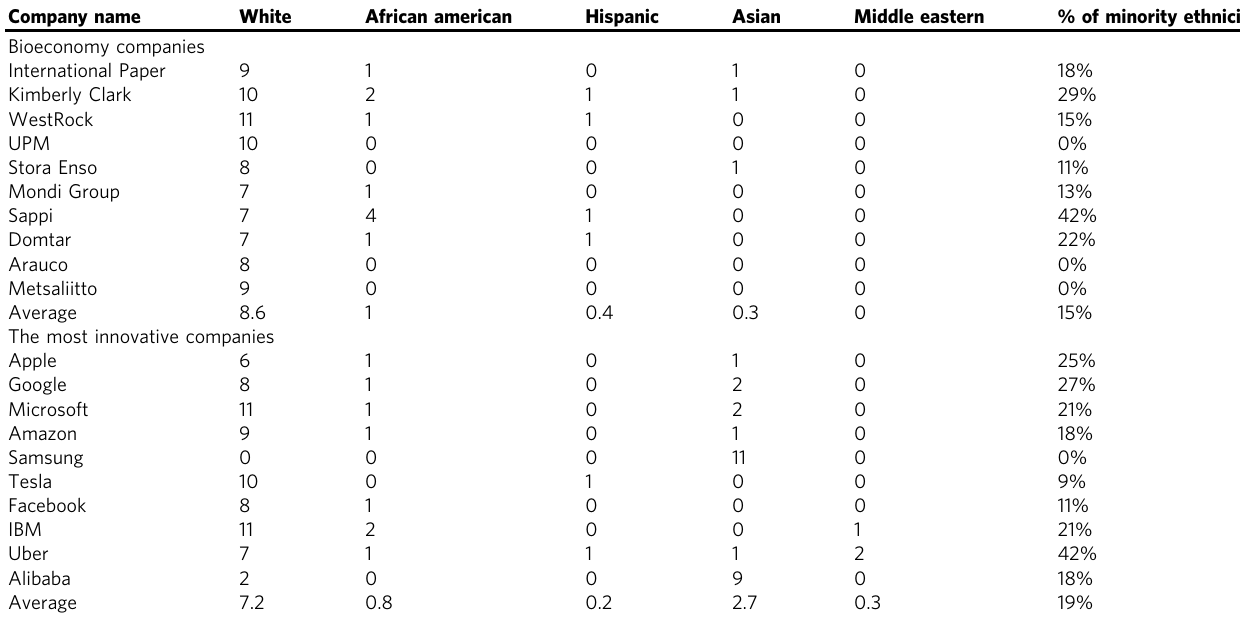
Table 3 Ethnic diversity in the bioeconomy and the most innovative company groups. Company name